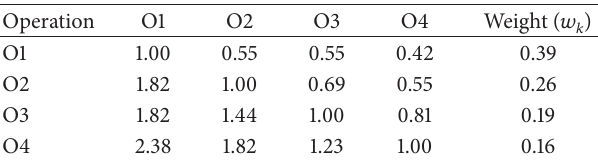
Table 6: The results of pair-wise comparison for subprecursors of Operation.